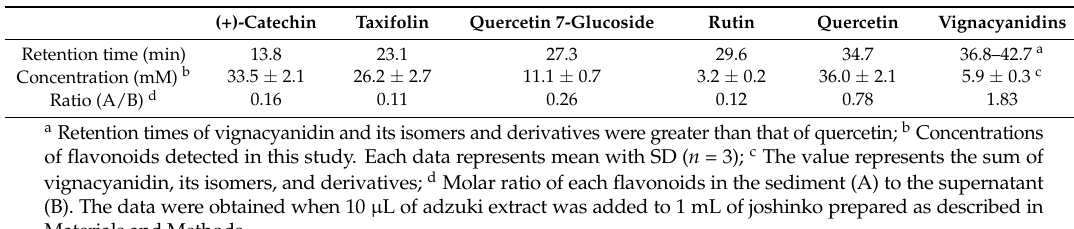
Table 1. Flavonoid concentrations in adzuki extract and molar ratio of each flavonoid in the sediment to the